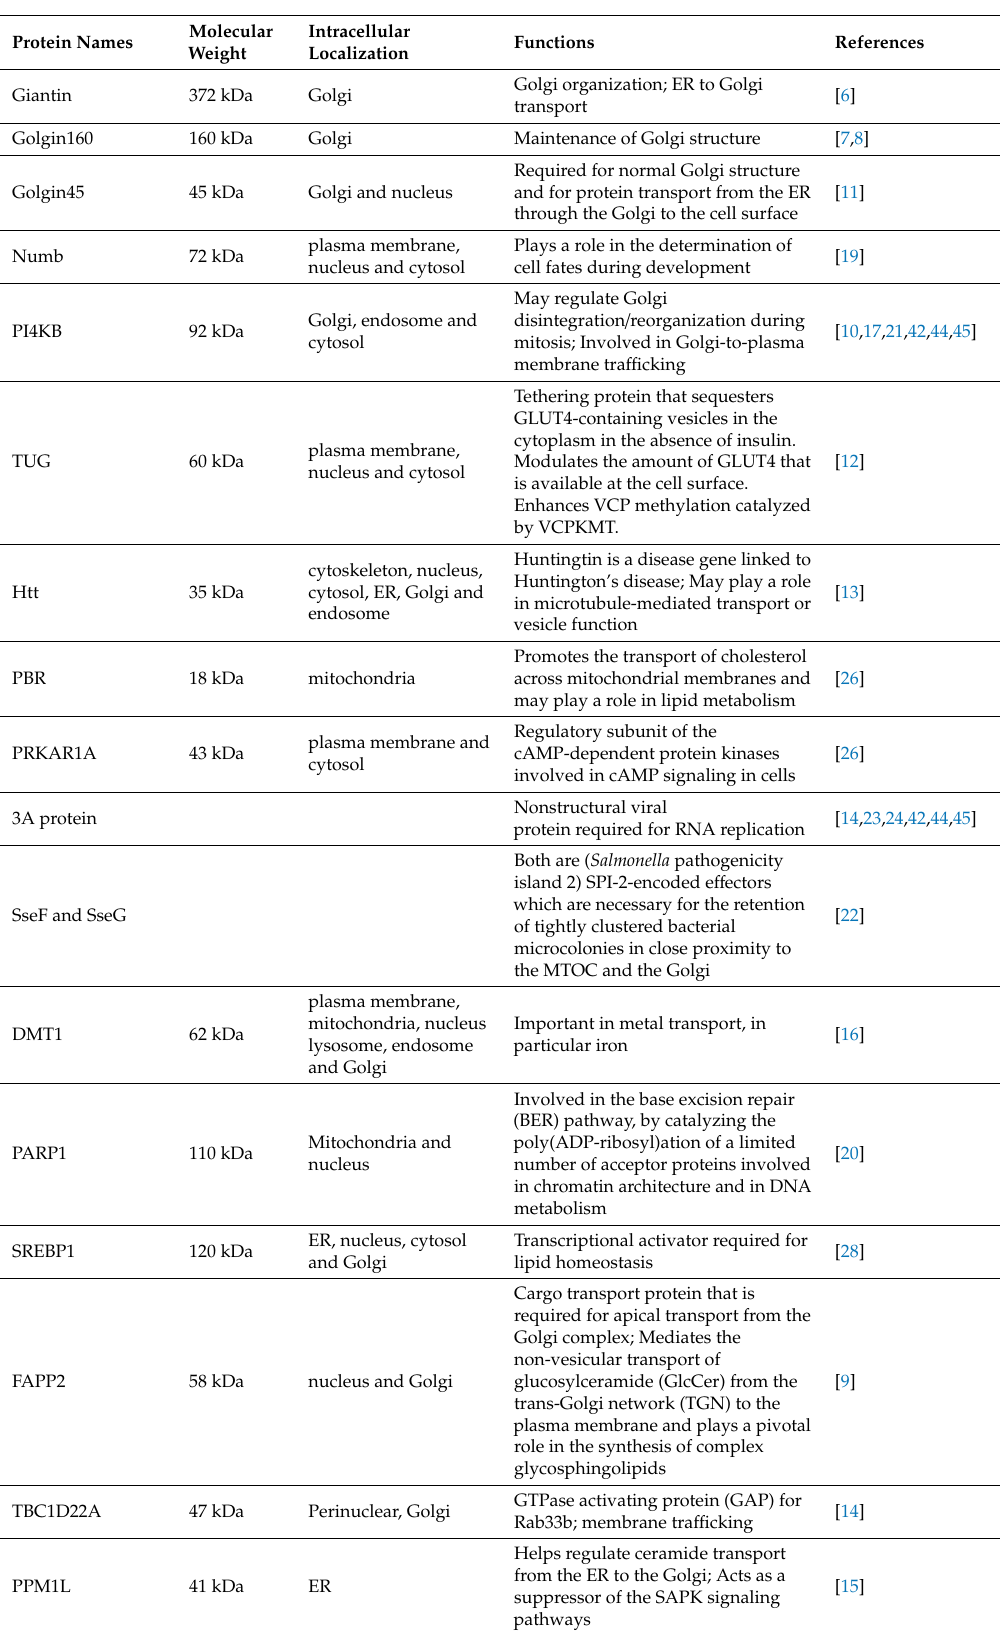
Table 1. Previously identified ACBD3-interacting